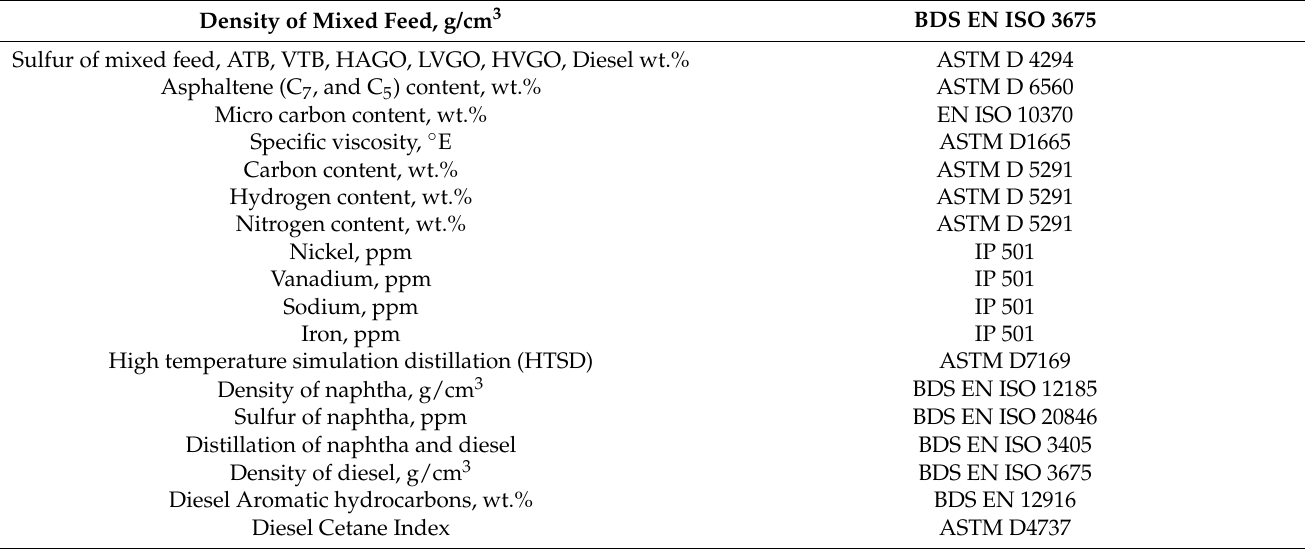
Table 6. Methods employed to measure properties of the LNB H-Oil ® mixed feed and liquid products. Density of Mixed Feed, g/cm 3 BDS EN ISO 3675 Sulfur of mixed feed, ATB, VTB, HAGO, LVGO, HVGO, Diesel wt.% ASTM D 4294 Asphaltene (C 7 , and C 5 ) content, wt.% ASTM D